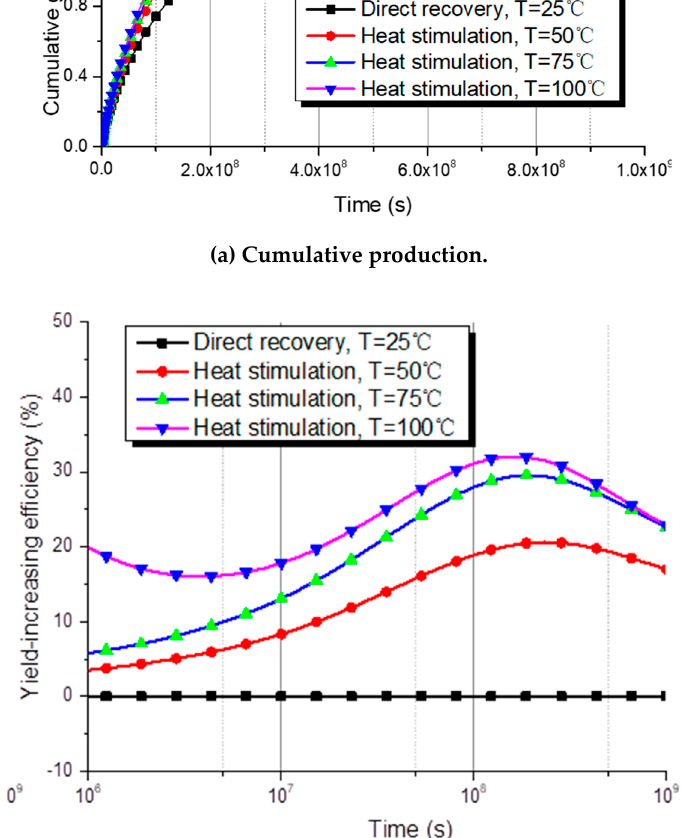
ff erent stimulation Figure 9. Gas production with different stimulation temperatures. Figure 9. Gas production with di